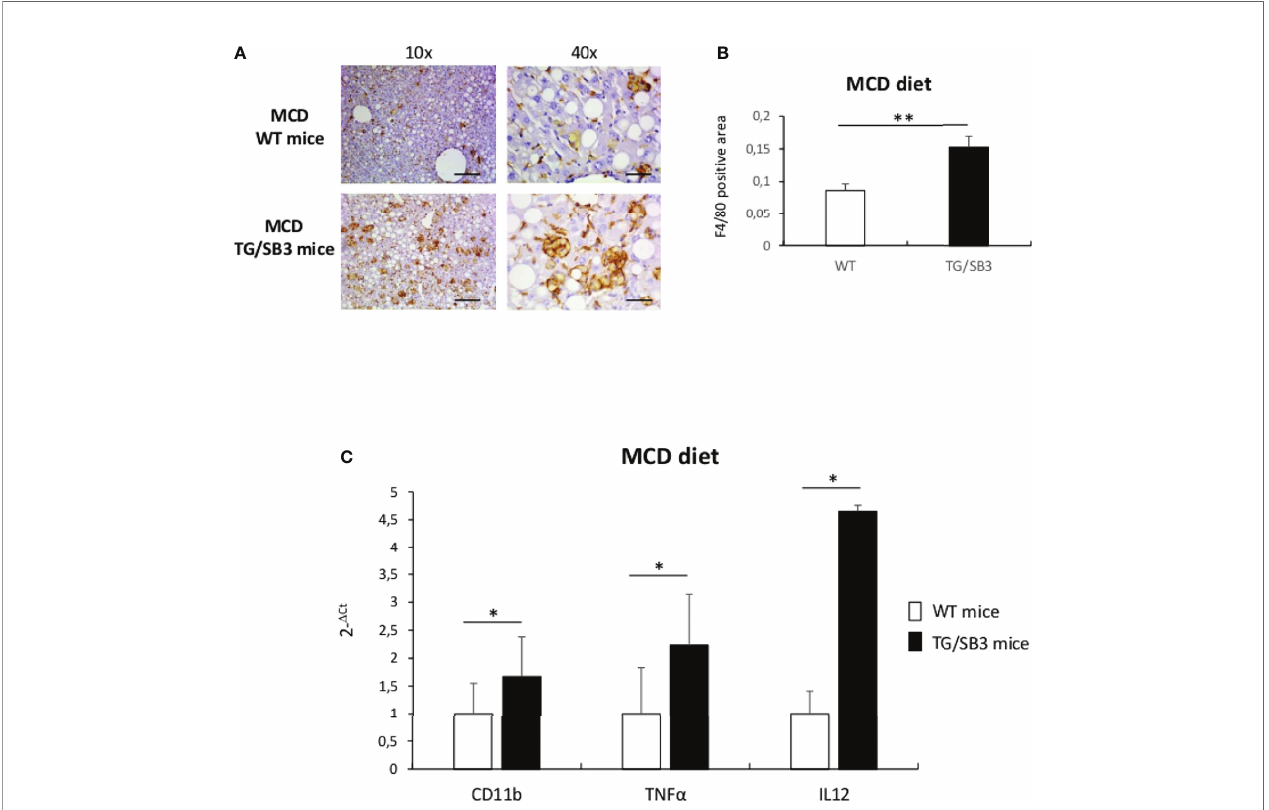
FIGURE 1 | (A – C) (A) Immunoistochemistry analysis for F4/80 on liver specimens obtained from C57Bl6J WT mice and C57Bl6J transgenic mice for SB3 (TG/SB3) fed on MCD diet for 8 weeks. Magni fi cation 10x, scale bar 200µm, magni fi cation 40x, scale bar 50µm. (B) ImageJ software analysis performed to evaluate the amount of F4/80 positive area in C57Bl6J WT mice and C57Bl6J transgenic mice for SB3 (TG/SB3) fed on MCD diet for 8 weeks. **p < 0.01 versus WT mice. (C) Quantitative real time PCR analysis of CD11b, TNF a and IL12 in C57Bl6J WT mice and transgenic mice for SB3 (TG/SB3) fed on MCD diet for 8 weeks. *p < 0.05 versus WT